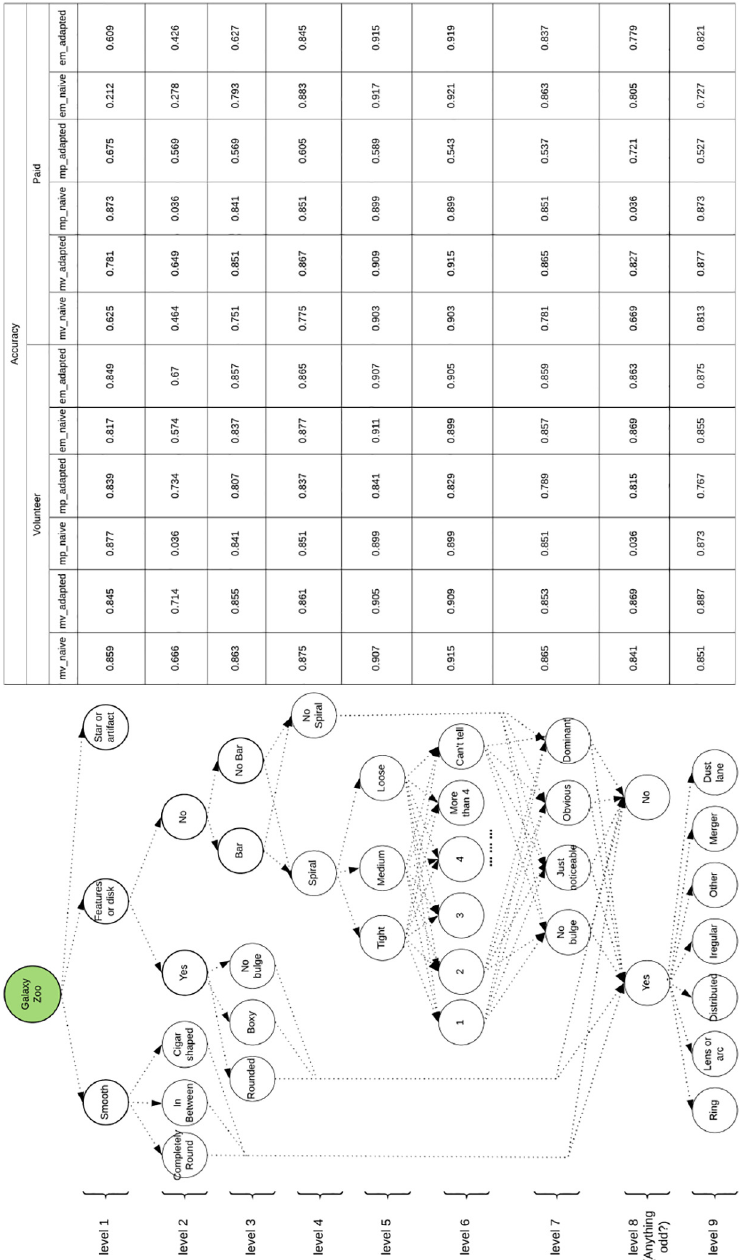
Figure 10. Accuracy by